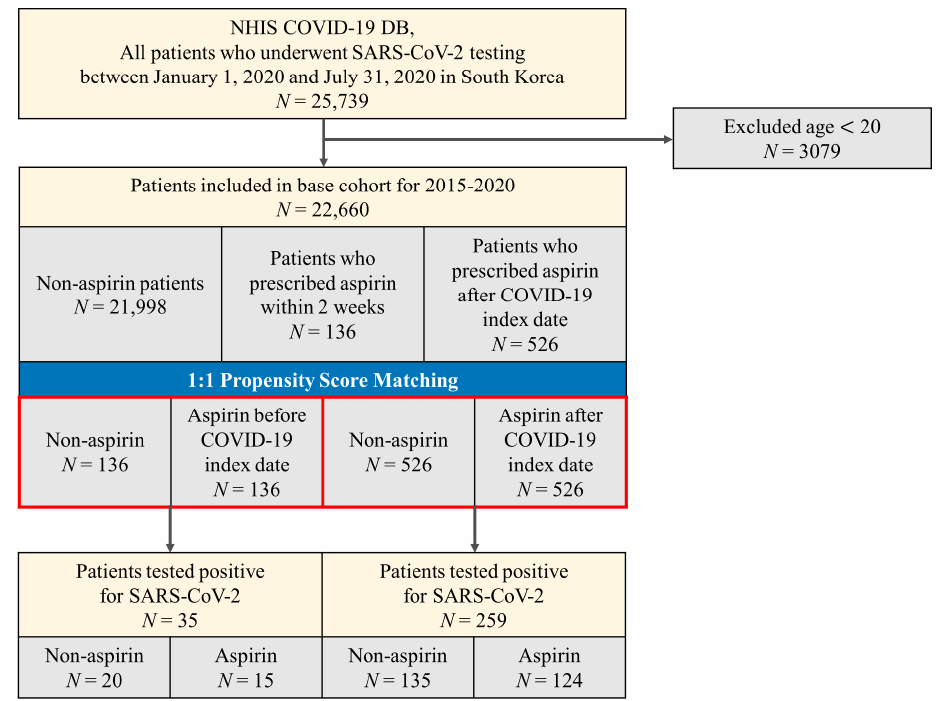
Figure 1. Disposition of patients in the Korean nationwide cohort.